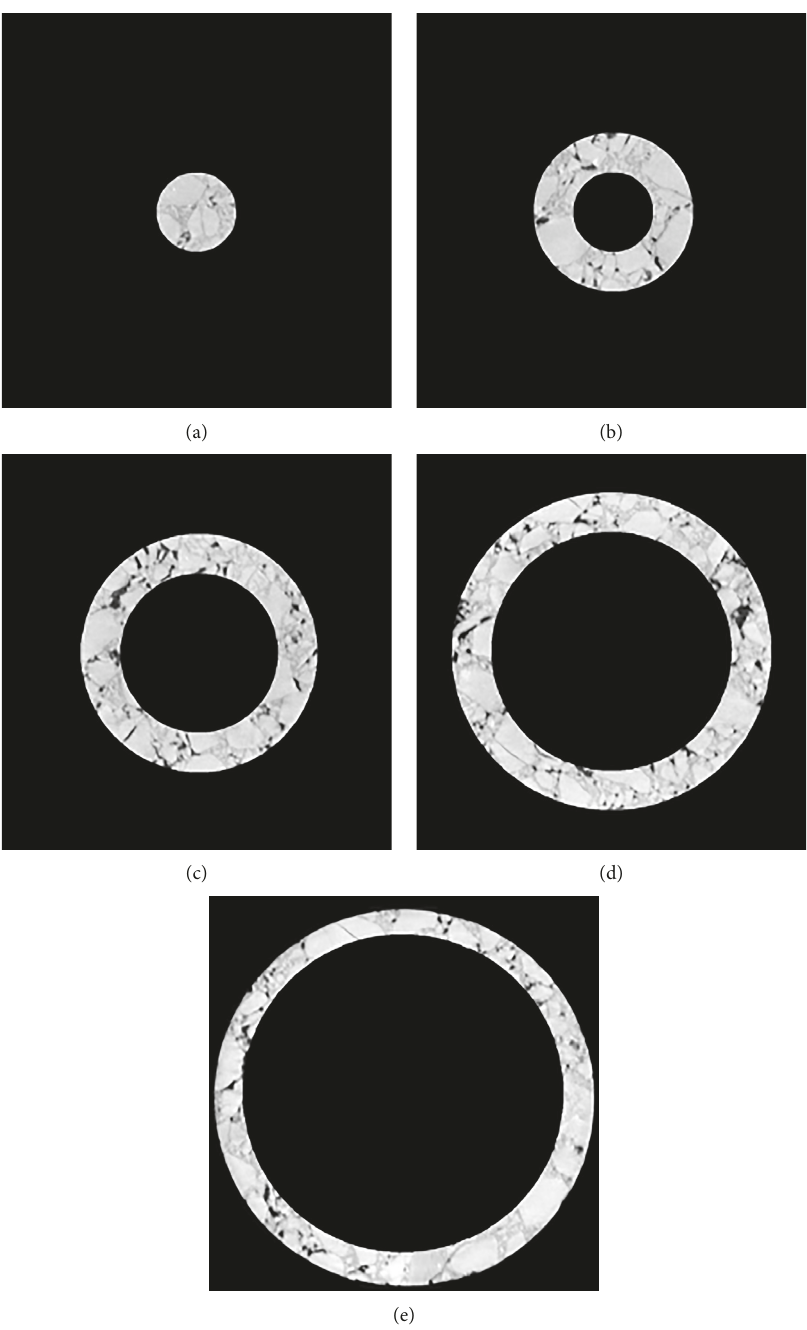
Figure 3: Subimage after segmentation: (a) central disk, (b) second ring, (c) third ring, (d) fourth ring, and (e) fifth